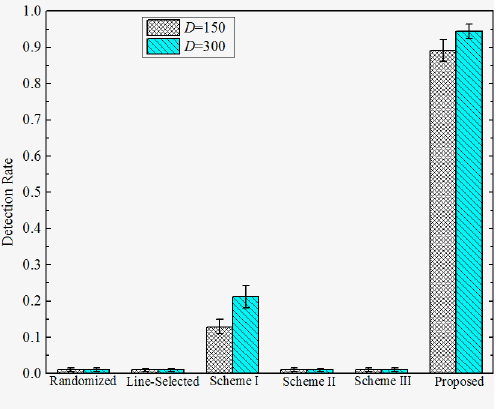
Figure 11. Detection rate of the proposed versus prior works under attack strategy III when σ = 100.